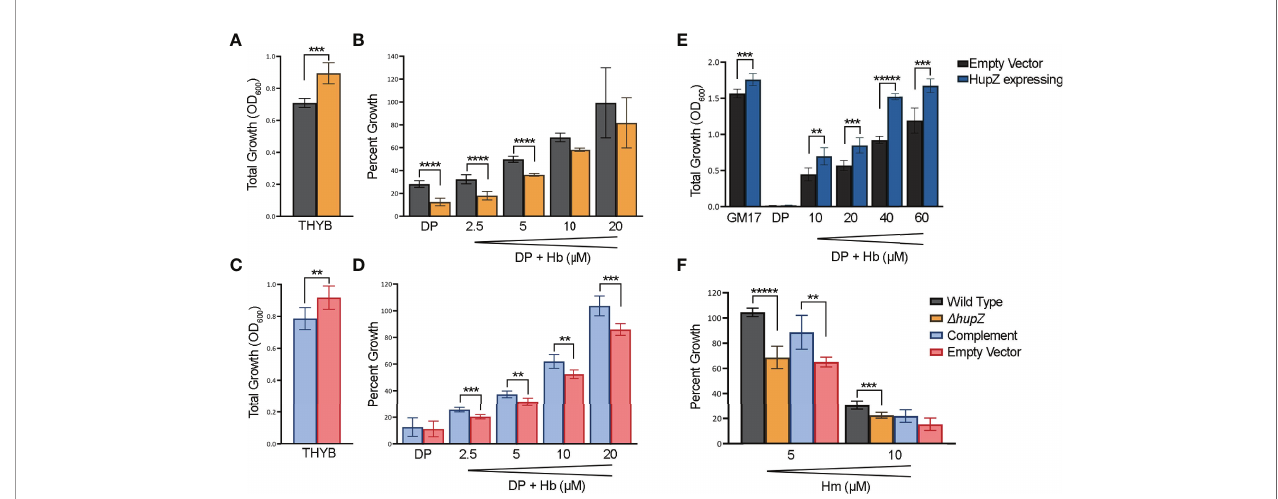
FIGURE 6 | HupZ contributes to bacterial growth on heme b-iron and aids GAS in heme b tolerance. Overnight growth of GAS wild-type rescue (gray) and D hupZ (orange) strains in THYB (A) . Relative growth of GAS wild-type rescue and D hupZ strains in THYB-DP with a range of hemoglobin (Hb) compared to THYB growth (B) . Overnight growth of complement (light blue) and empty vector (pink) in THYB (C) . Relative growth of GAS D hupZ strain with HupZ expressing (light blue, complement) or empty vector (pink) in THYB-DP with a range of HB (D) . Overnight growth of L. lactis in GM17 (E) , GM17-DP, or GM17-DP and a range of Hb, with either an empty (black) or HupZ expressing vector (dark blue). Relative growth of GAS wild-type rescue, complement, and empty vector strains in THYB with either 5 or 10 m M heme (Hm) compared to normal THYB growth (F) . The data represent three independent experiments and were analyzed using the Student ’ s t -test, where ** indicates a P-value > 0.001, *** > 0.0001, **** > 0.00001, and ***** > 0.000001.